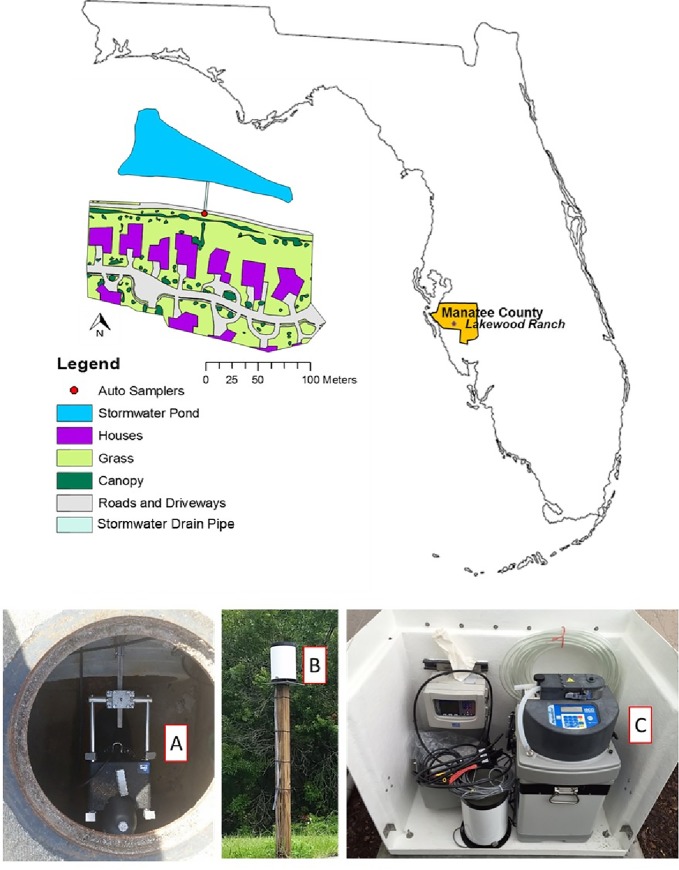
Location map of the study site and residential catchment and various instruments installed in the stormwater outlet pipe, including A) laser flow meter, B) rain gauge, and C) autosampler. The location map of the catchment was made using open data source, freely available at
http://geodata.myflorida.com/datasets/swfwmd::florida-counties in ArcGIS 10.3.1 version.